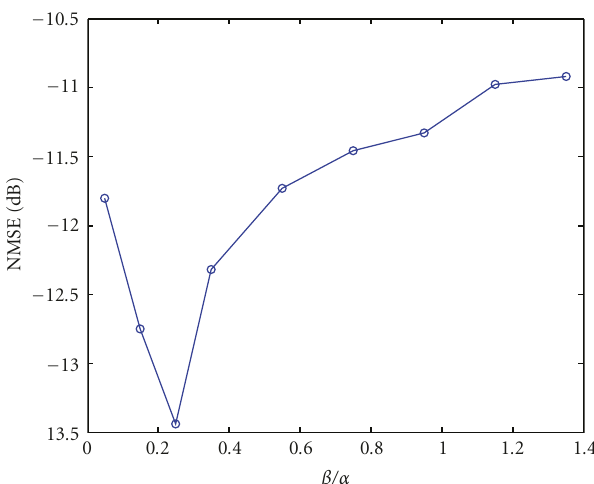
Figure 5: The e ff ect of parameters in (13) in identification